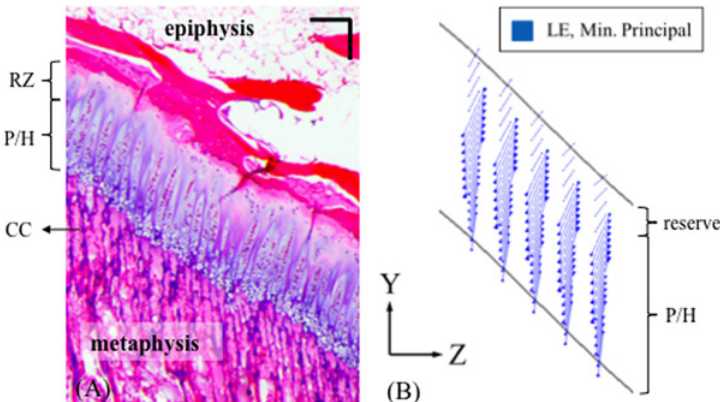
Fig 11. Chondrons appear to be oriented along the minimum principal strain directions, becoming roughly perpendicular to the epiphyseal bone plate, whereas the hypertrophic portion along with the calcified cartilage bars and primary spongiosa align more with the primary compressive load direction along the tibial long axis (Y). (A) Histology slice of a 4-month old bovine proximal tibial growth plate stained with H&E, scale bar = 200 μ m. (B) Minimum principal strain vector plot at the central region of the ‘ m ’ shape growth plate. The results were obtained from the mesoscale model without the cellular